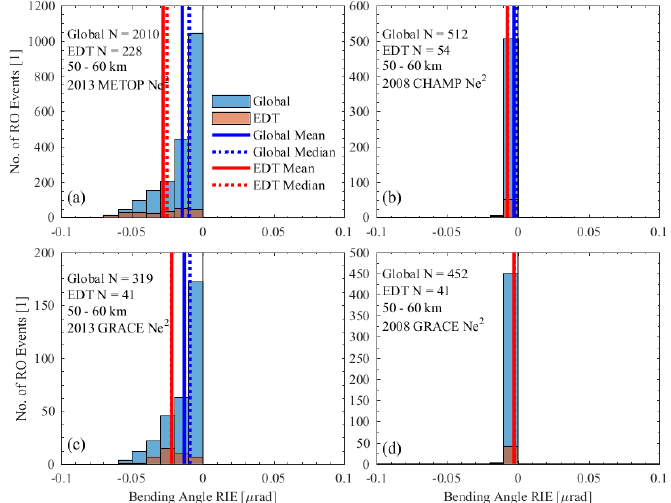
Figure 11. Relationship between the histogram distribution of the number of RO events and the average value of the bi-local Ne 2 term over 50–60 km impact altitude range for high solar activity data (left column, MetOp-A/-B ( a ) and GRACE ( c ) on 15 May and 15 July 2013) and low solar activity data (right column, CHAMP ( b ) and GRACE ( d ) on 14–16 July 2008). In each panel, the global (blue) and EDT (red) ensembles are presented as well as the global mean, global median, EDT mean, and EDT median as vertical lines in the corresponding colors (see legend in panel ( a )).